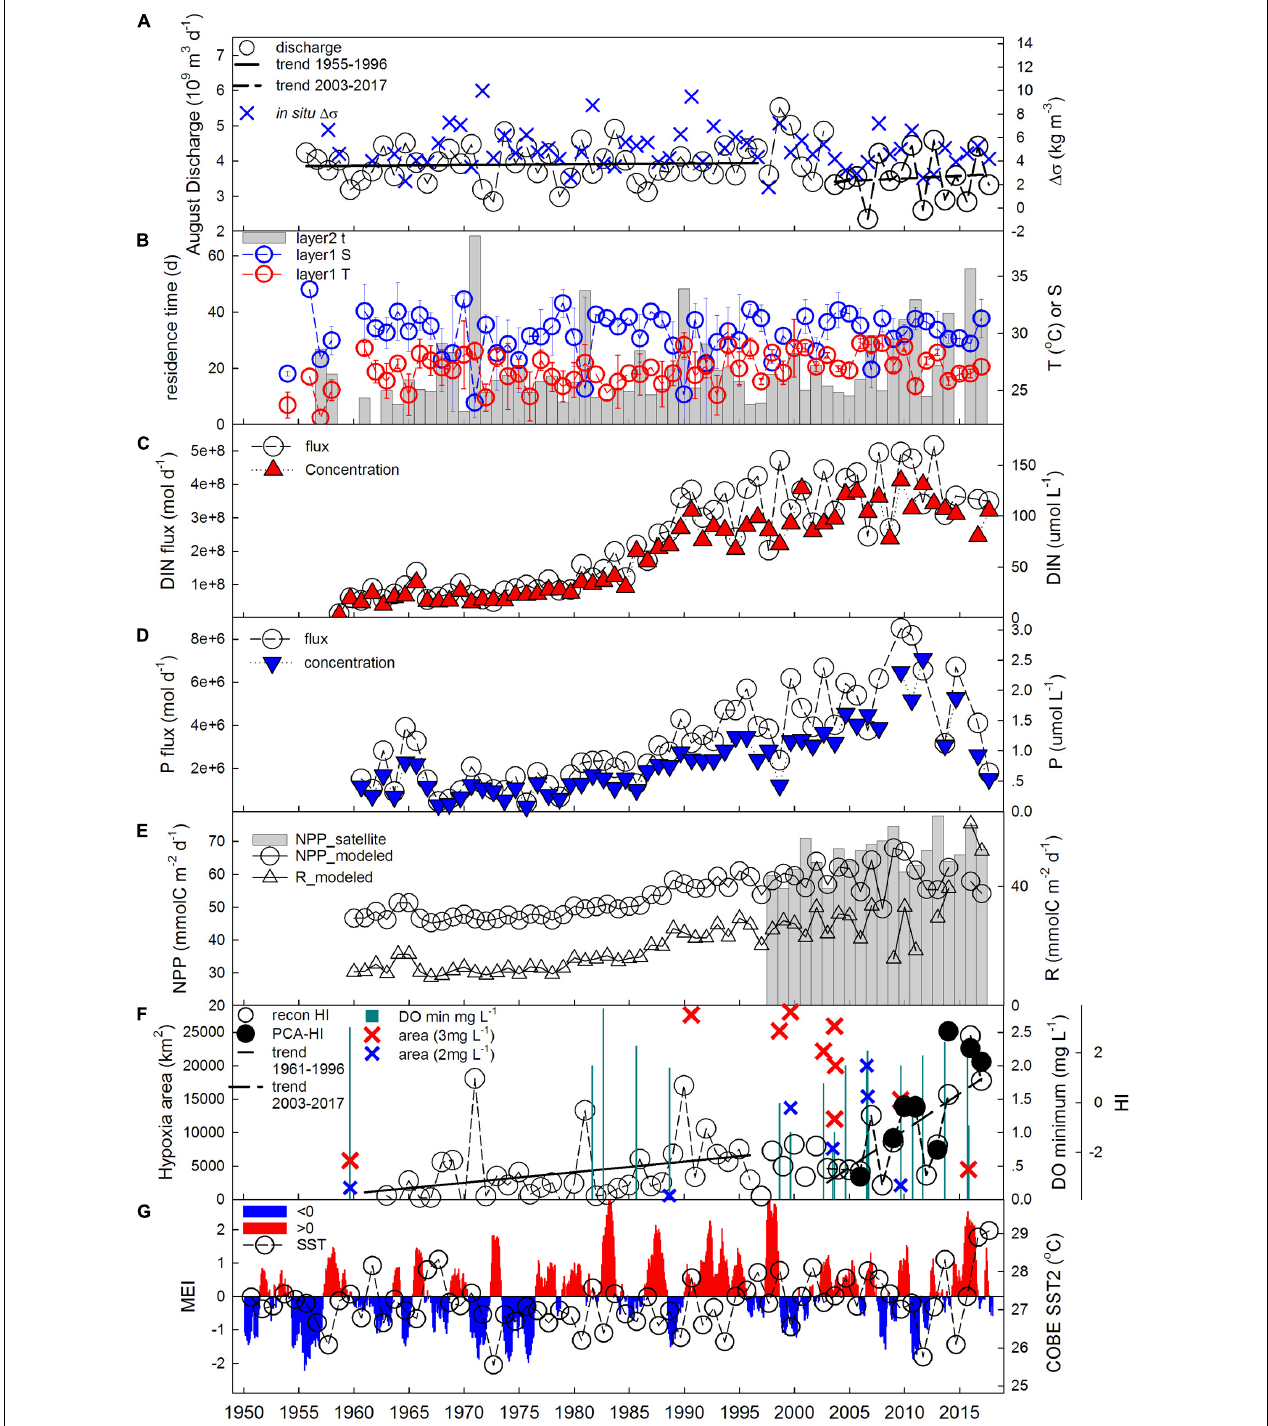
FIGURE 4 | Long-term variation of (A) Changjiang River discharge in August and averaged density difference between bottom and surface ( (cid:49) σ ); (B) averaged temperature (T) and salinity (S) in layer 1 using historical data and water residence time in layer 2 derived from LOICZ model. (C) DIN (DIN = NO 3 − + NO 2 − + NH 4 + ) concentration and flux and (D) DIP concentration and flux in the fresh water endmember in Changjiang River; (E) averaged NPP derived from satellite along 31 ◦ N transect using the SatCO 2 platform, modeled NPP based on Eq. 11, and modeled respiration in the hypoxia area (R hy ); (F) plane area of bottom hypoxia region ( < 3 and < 2 mg L − 1 ) and DO concentration minimum in historical records (Gu, 1980; Tian et al., 1993; Li et al., 2002; Quan et al., 2005; Wei et al., 2007; Pei et al., 2009; Li et al., 2018), compared with reconstructed (recon) and PCA-derived hypoxia index (HI); (G) MEI (multivariate ENSO index) and averaged August SST (COBE-SST2 from NOAA) at 31 ◦ N transect in Changjiang plume-impacted shelf area.